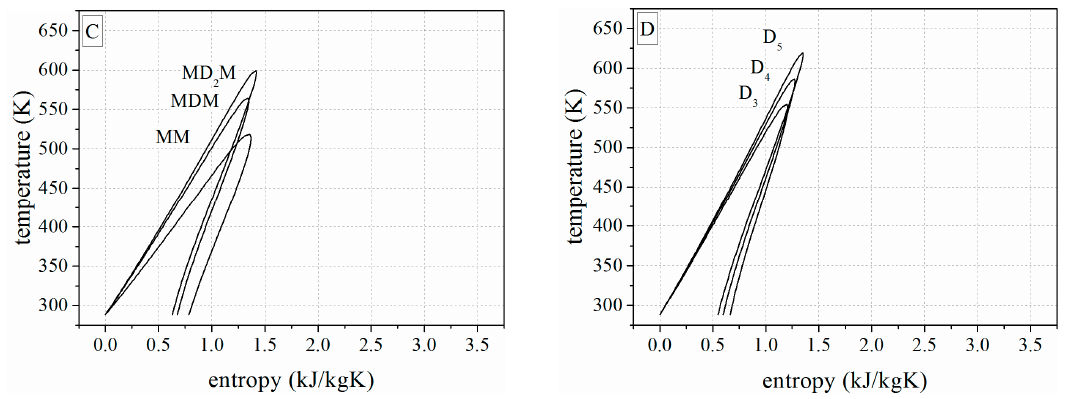
Figure A1. T,s -diagrams of investigated working fluids ( A ) n -alkanes; ( B ) alkylbenzenes; ( C ) linear siloxanes; and ( D ) cyclic